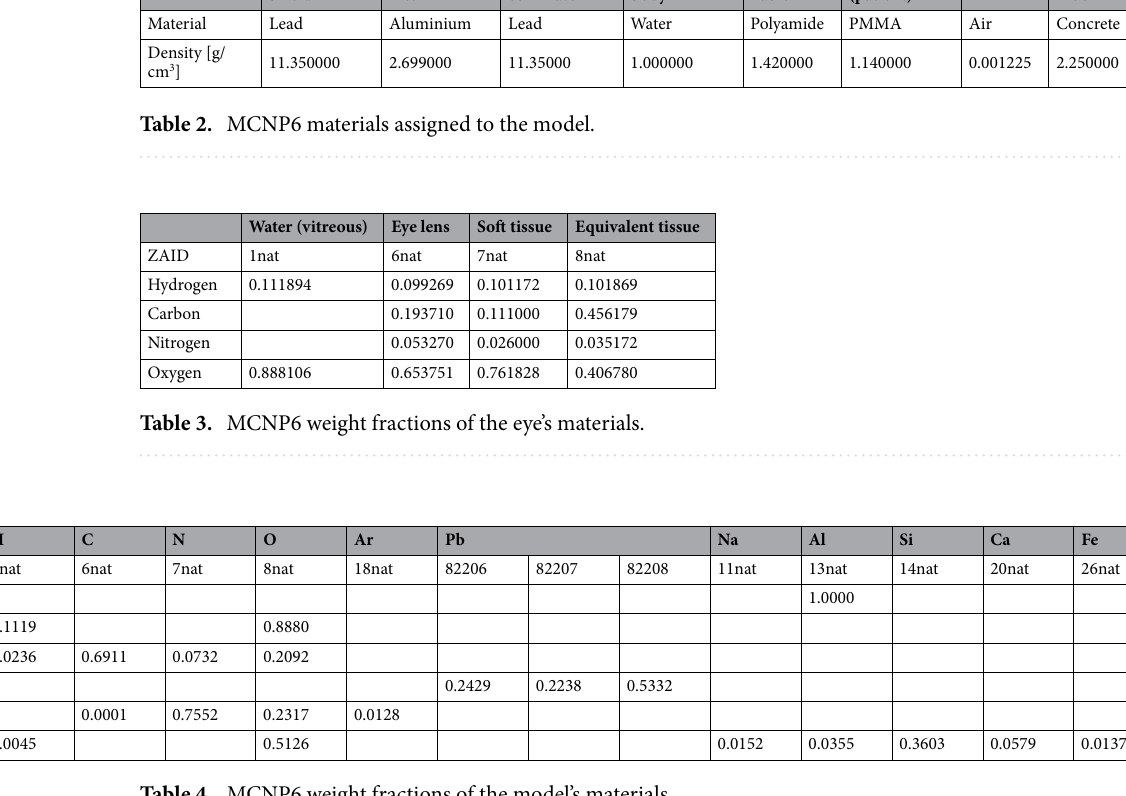
Table 4. MCNP6 weight fractions of the model’s materials.